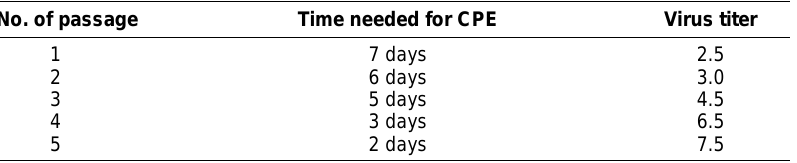
Table-1. Propagation and titration of local isolated IBD variant strain on BGM- 70 cell lines: No. of passage